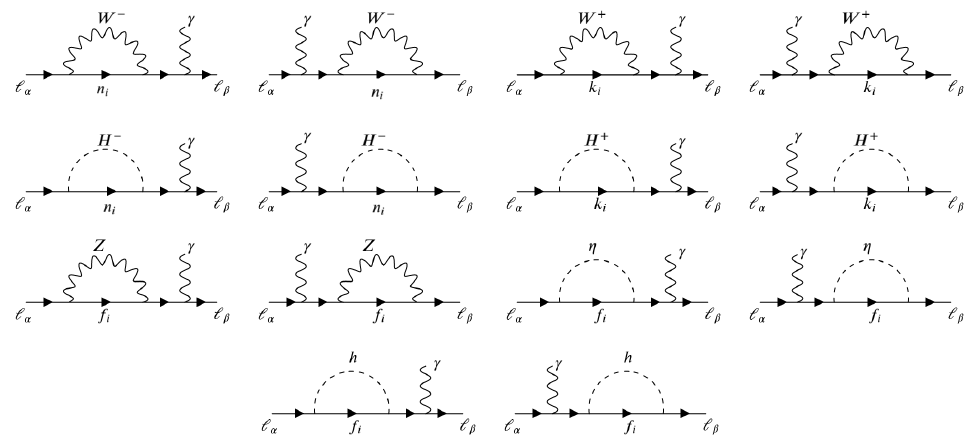
Figure 3 . Self-energy diagrams. n i , f i and k i symbollically stand for any of the neutral, singly- charged and doubly-charged fermions,